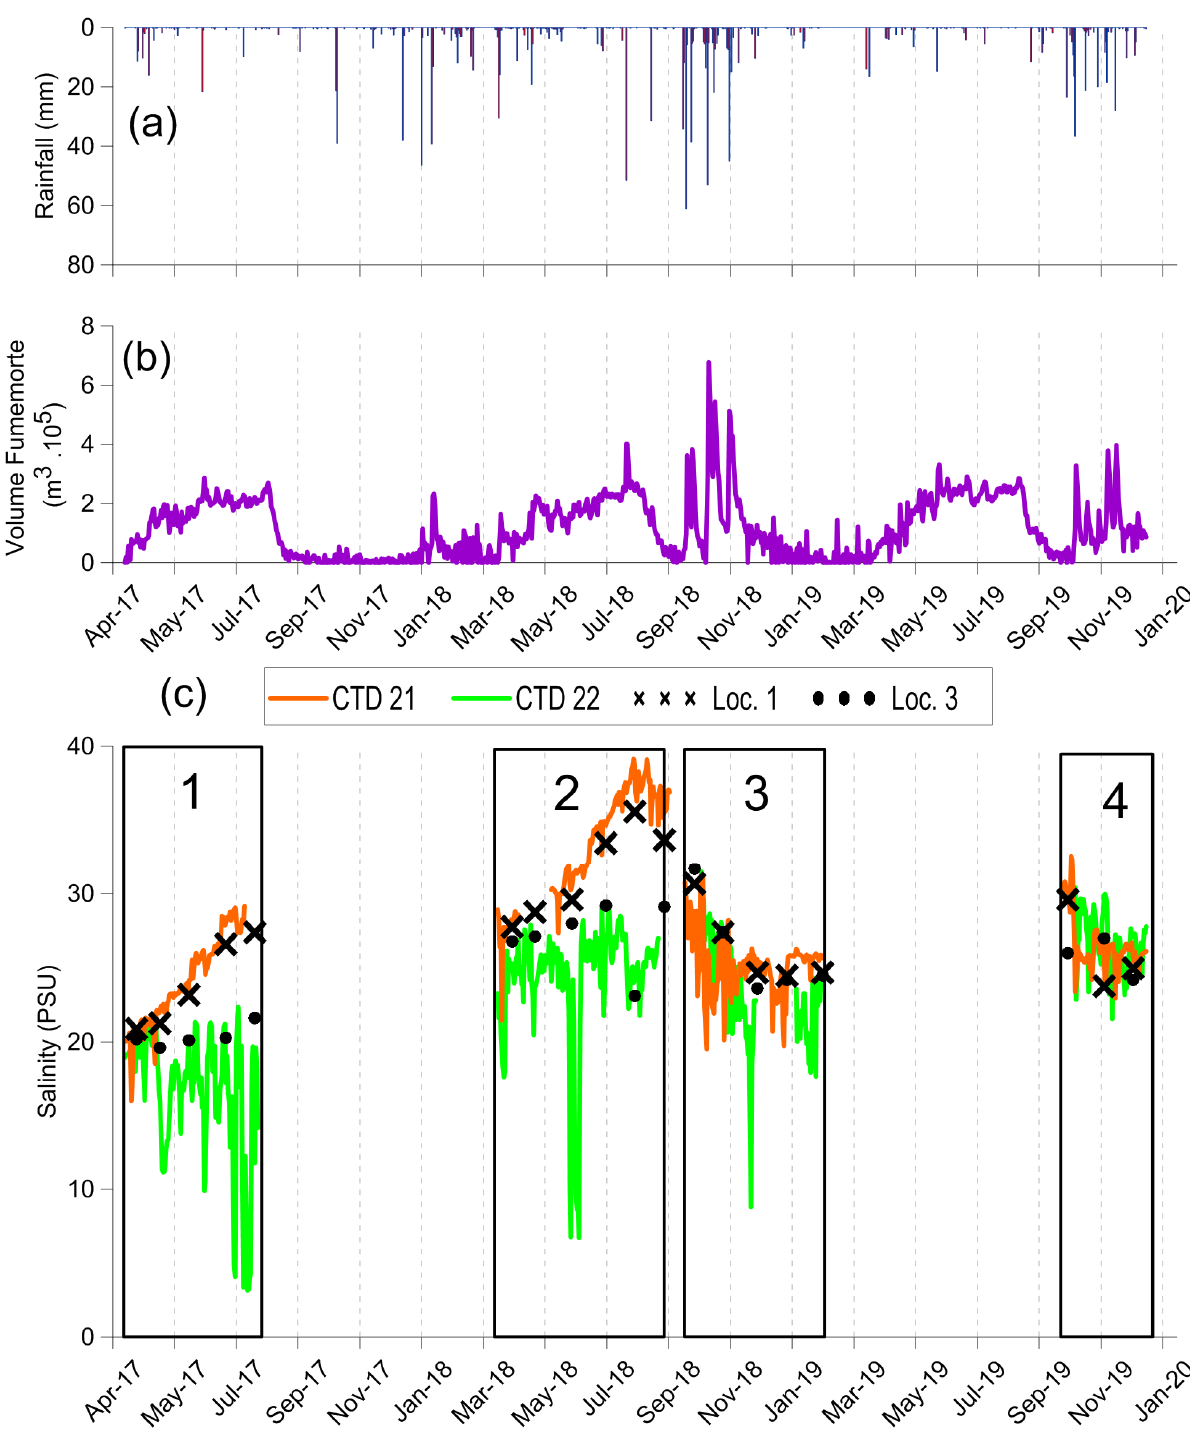
Figure 4. ( c ) Daily averaged salinity measured at locations 21 and 22 (Figure 2) from 13 April 2017 to 31 December 2019. Monthly in situ salinity measurements are also represented. ( b ) Volume of water entering the Vaccar è s lagoon through the Fumemorte channel, measured with the flowmeter at location 23. ( a ) Precipitation data. Regarding the salinity data of the two CTD probes, the absence of a line indicates missing data, due to instrumental problems (probe clogging) or water levels too low for the conductivity sensor to remain